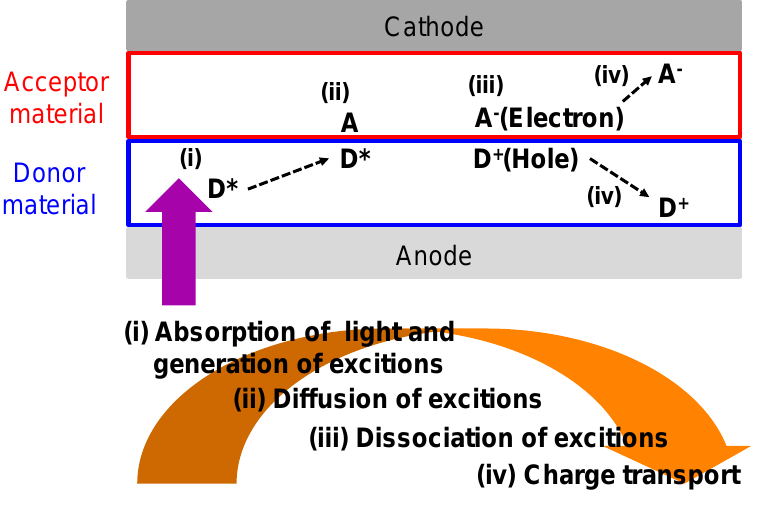
Figure 2. Four fundamental steps for the energy conversion process in solar cells; (i) absorption of light and generation of excitons; (ii) diffusion of the excitons; (iii) dissociation of the excitons; and (iv) charge transport and charge